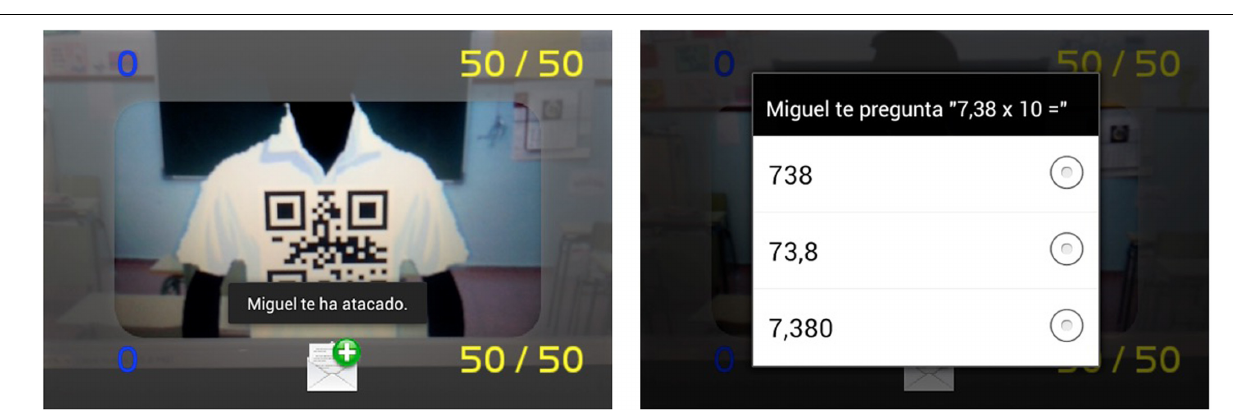
FIGURE 9 | Validation of an expulsion by the student